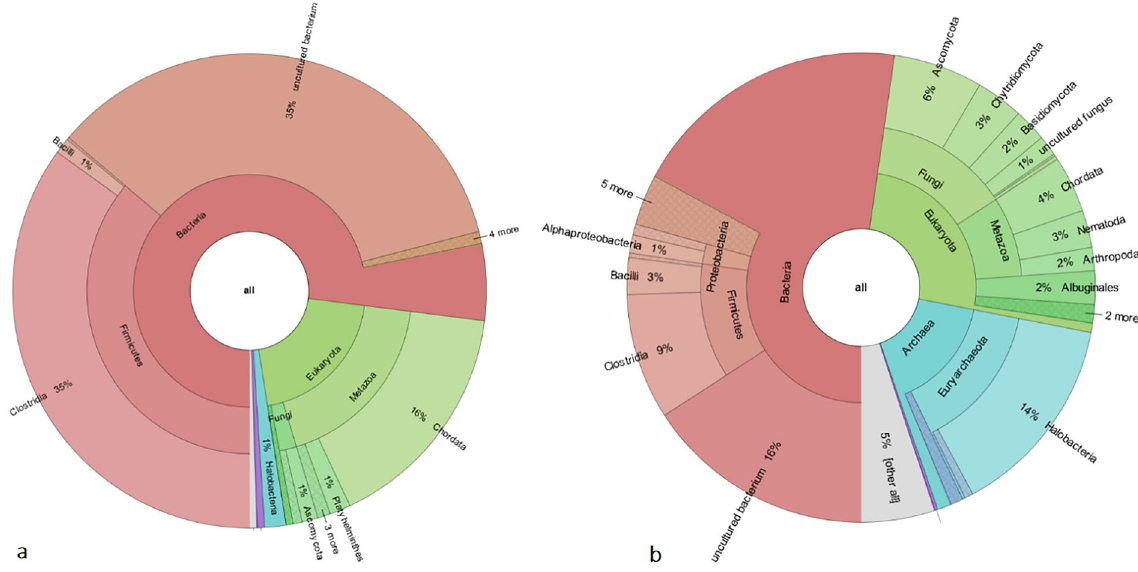
Figure 3. Krona charts of two selected samples: ( a ): sample 9, ( b ): sample 1. Edited by Microsoft paint, version 21 H2, https:// www. micro soft. com/ en- us/ windo